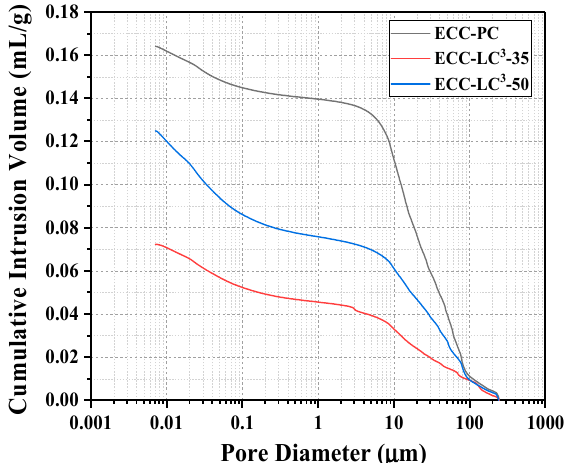
Figure 5. Pore distribution.